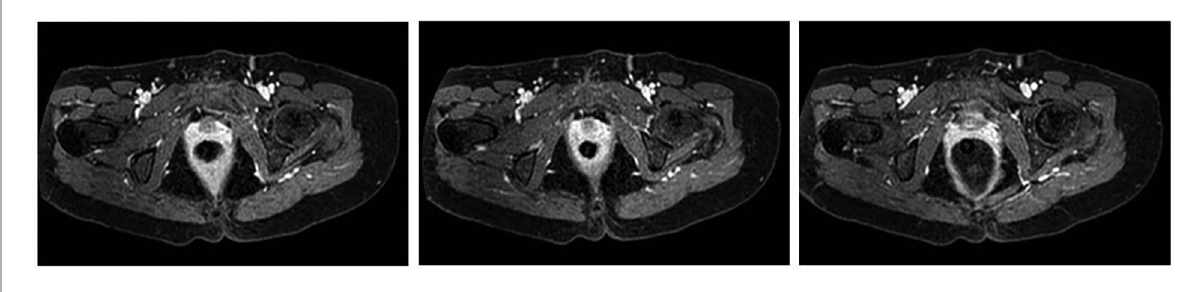
FIGURE 1 MRI illustration of the colorectal lesion with inhomogeneous signal intensity and involvement of serosa, muscular layers, and